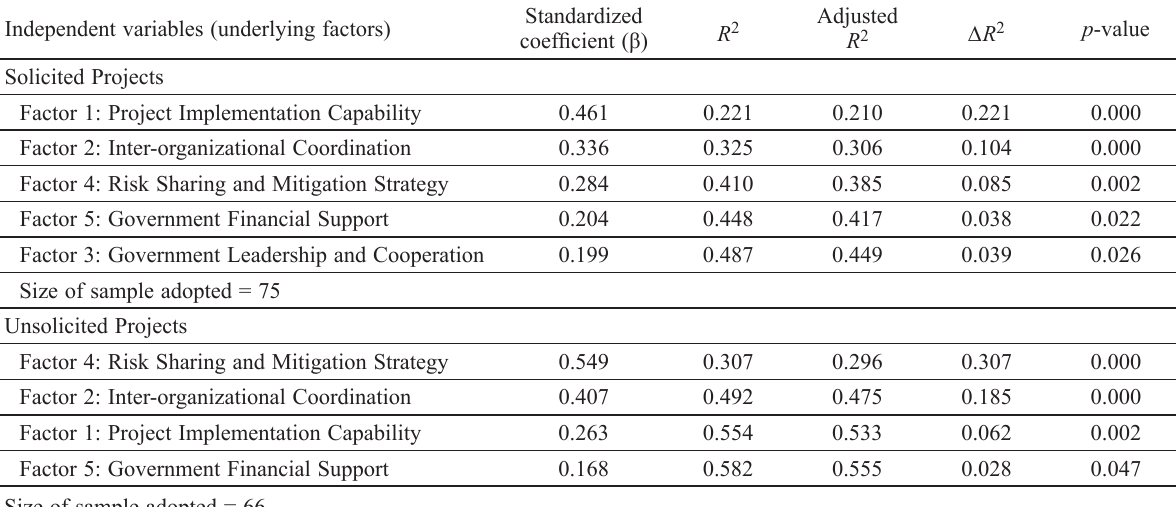
Table 4. Stepwise multiple regression results in solicited and unsolicited projects Independent variables (underlying